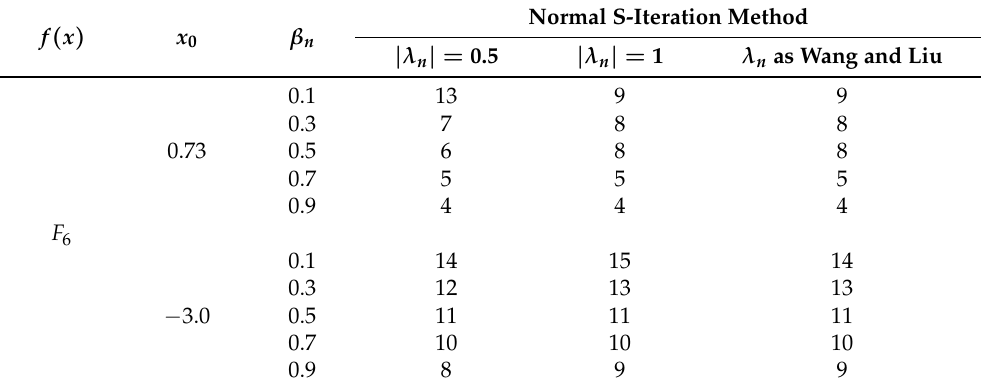
Table 3. The proposed method for different values of λ n and β n